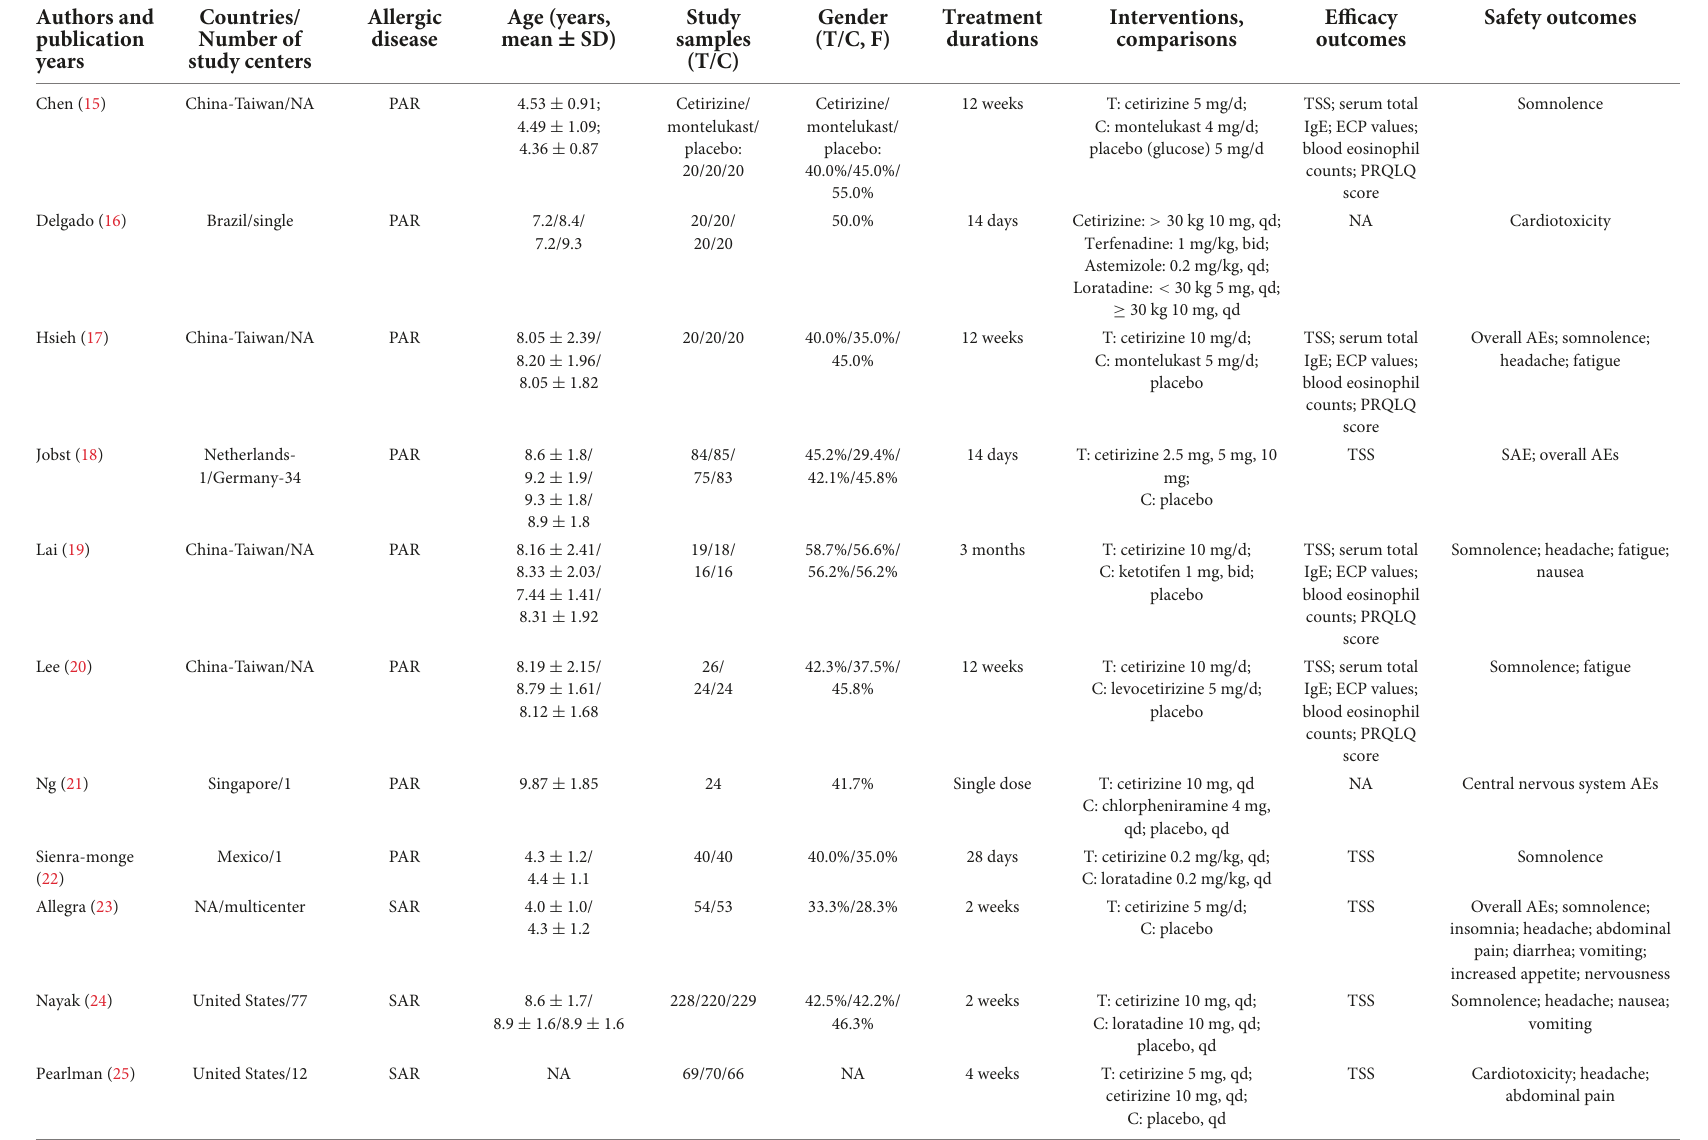
TABLE 1 Baseline characteristics of included